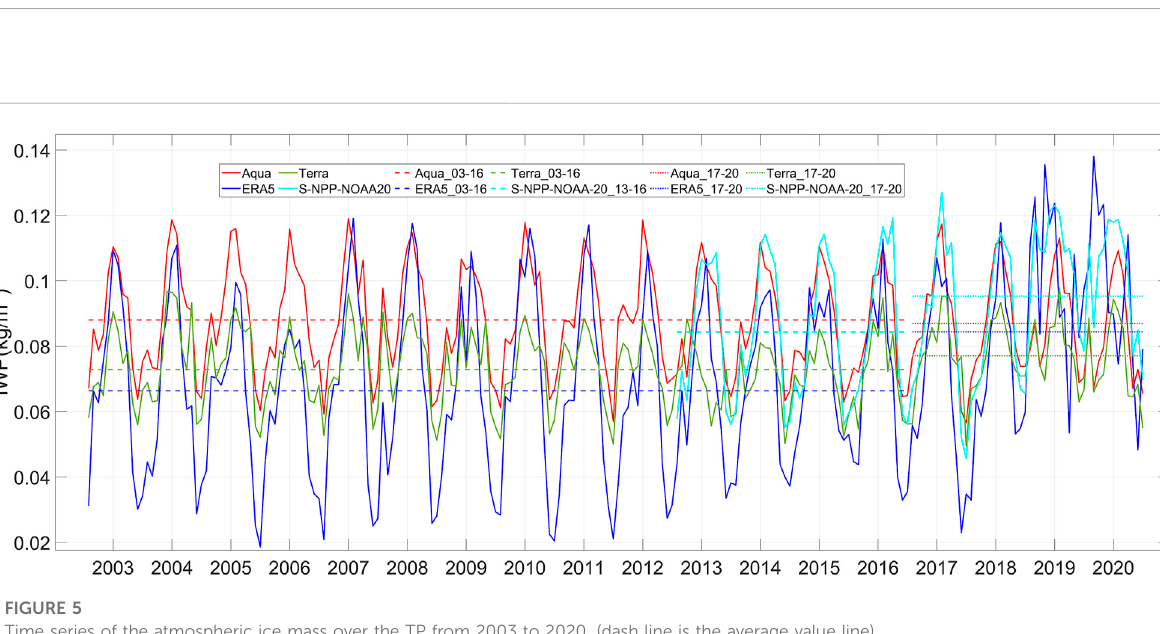
condition for the formation of atmospheric ice. In addition, strong updraft carried abundant water vapor to high altitudes, producing lots of atmospheric ice through condensing. The previous two